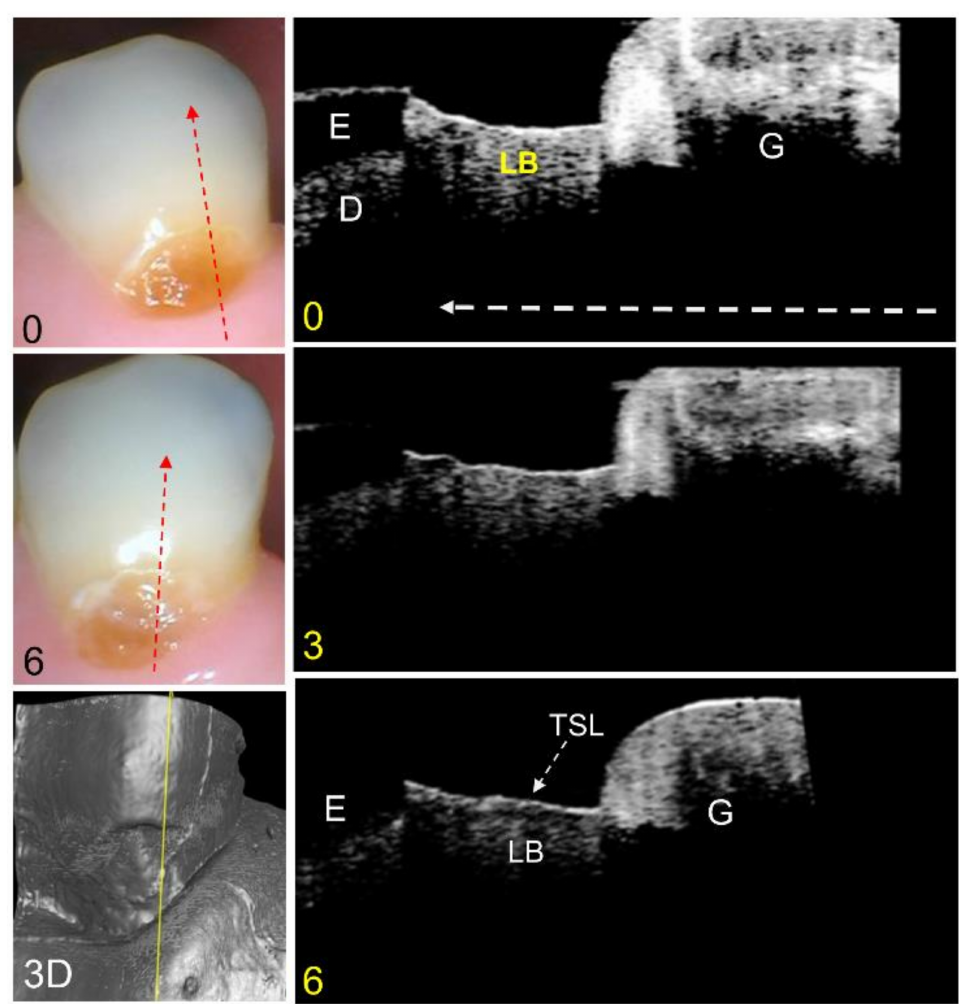
Figure 4. Color pictures at baseline and 6 months are shown for an active lesion that has undergone increasing remineralization and has a TSL after 6 months. The dashed red lines show the likely position of the three CP-OCT b-scans shown at baseline, 3 months, and 6 months. The white dashed arrow in the OCT b-scan is directed from the root to the crown. A surface rendering (3D) of the entire CP-OCT scan taken at 0 months is also shown, with the yellow line showing the position of the extracted b-scans. The position of the gingiva (G), enamel (E), and underlying dentin (D) are shown, and the lesion body (LB) is indicated. After 6 months, the intensity of reflectivity from the lesion body has decreased, and a distinct TSL is visible at the lesion